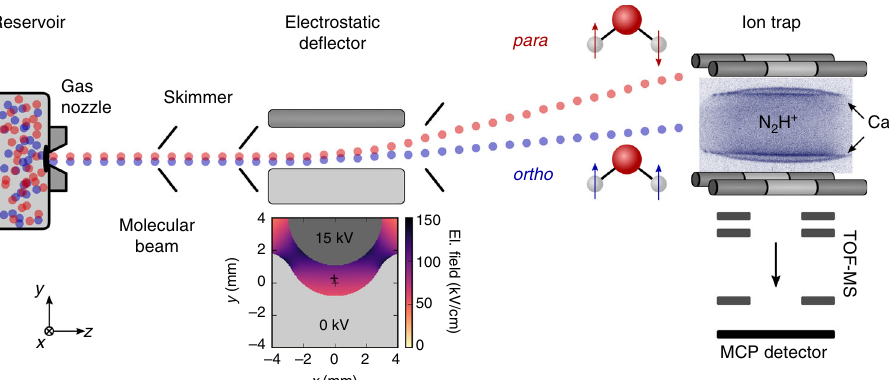
Fig. 1 Schematic of the experimental setup. A pulsed molecular beam of water molecules seeded in argon emanates from a room-temperature reservoir through a pulsed gas nozzle and passes an electrostatic de fl ector. The inhomogeneous electric fi eld inside the de fl ector (shown in the inset below) spatially separates para- and ortho- water molecules due to their different effective dipole moments. After the de fl ector, the beam is directed at an ion trap containing a Coulomb crystal of Ca + and sympathetically cooled N 2 H + reactant ions (inset image). The products and kinetics of reactive collisions between N 2 H + and H 2 O are probed using a time-of- fl ight mass spectrometer (TOF-MS) 27